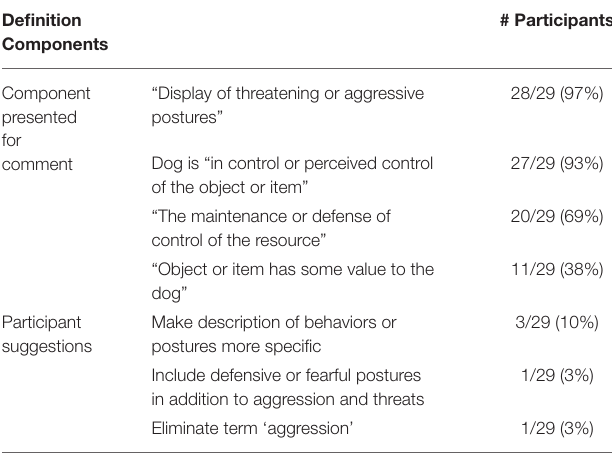
TABLE 3 | Agreement with components of a definition gathered from survey stage 1 and presented in stage